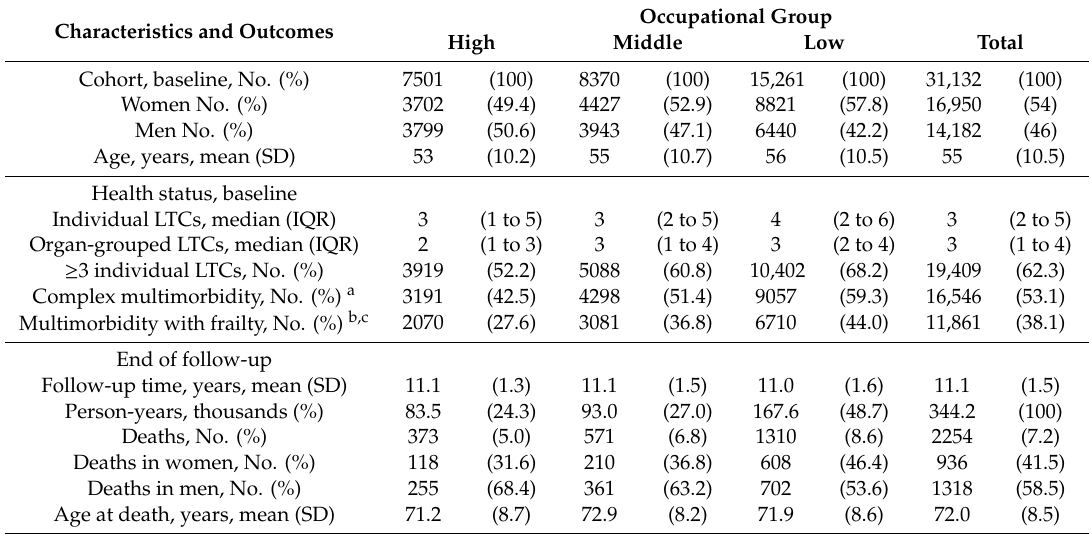
Table 1. Sociodemographic characteristics and health profile at baseline and follow-up time and events in occupational strata, the HUNT Study 2006–2008 (HUNT3).